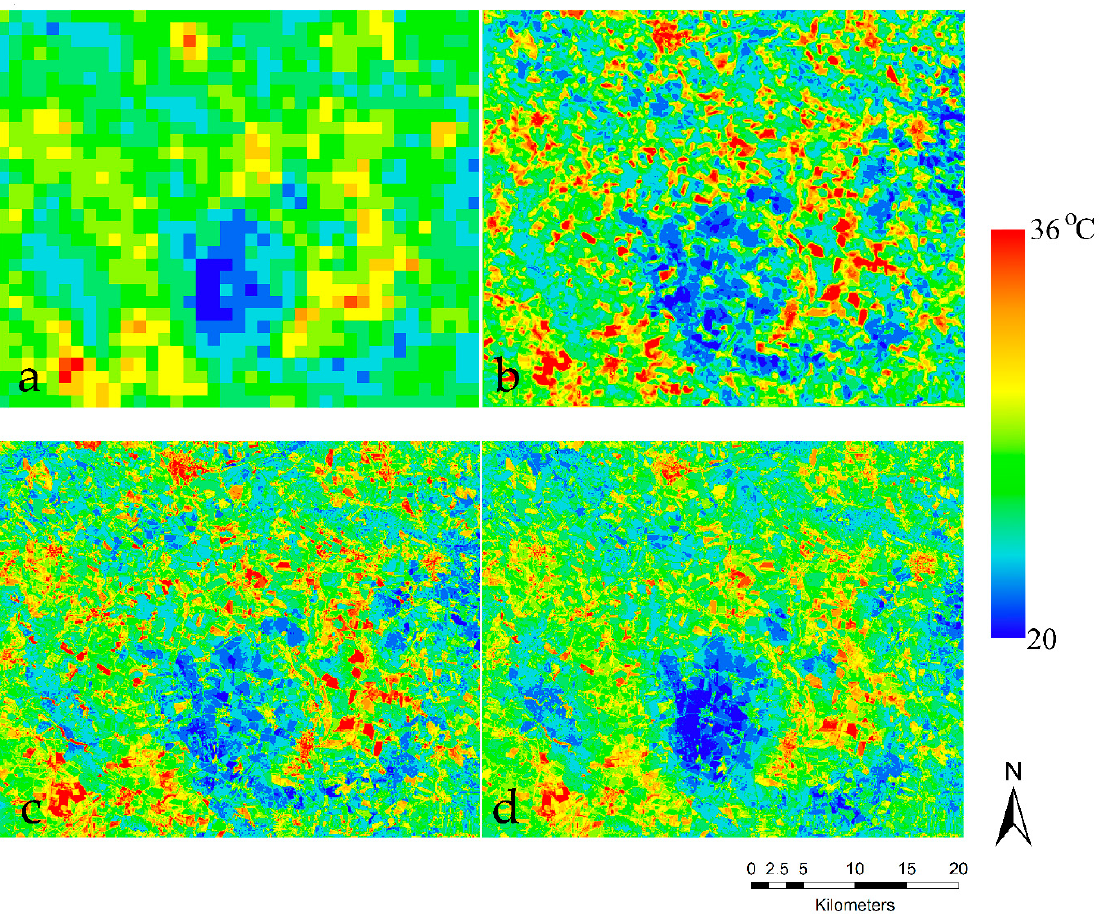
Figure 6. Sharpening BT images from a 960-m to 60-m resolution for Site 2. ( a ) Sentinel-3 BT at 960 m. ( b ) Reference Landsat 8 BT at 60 m. ( c ) Sharpened to 60-m BT derived from applying TsHARP